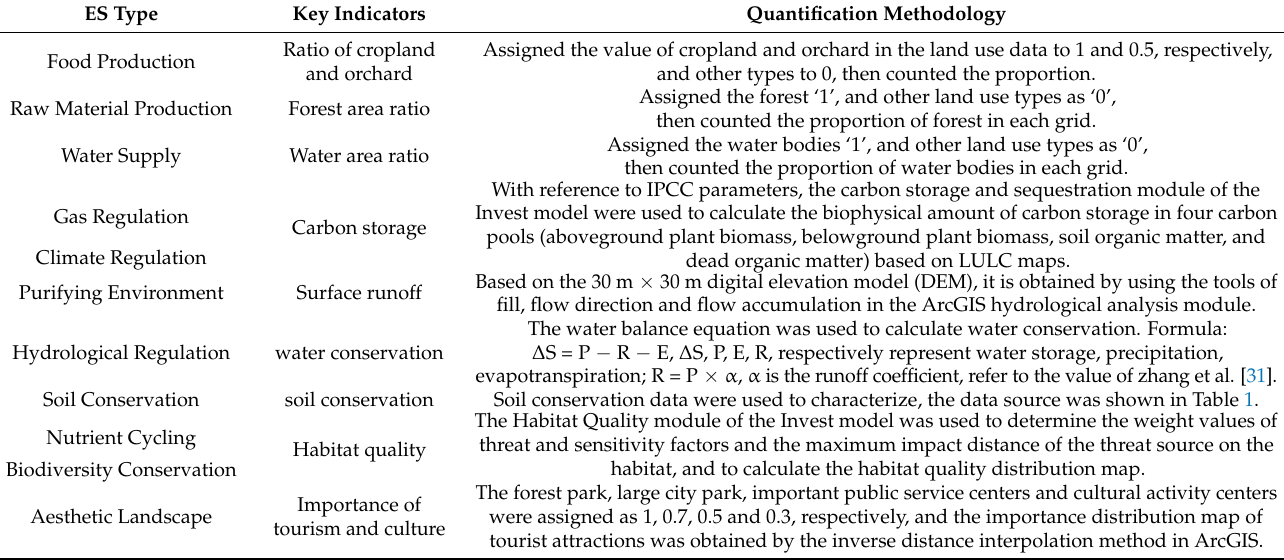
Table 4. Methods for spatial agglomeration degree of